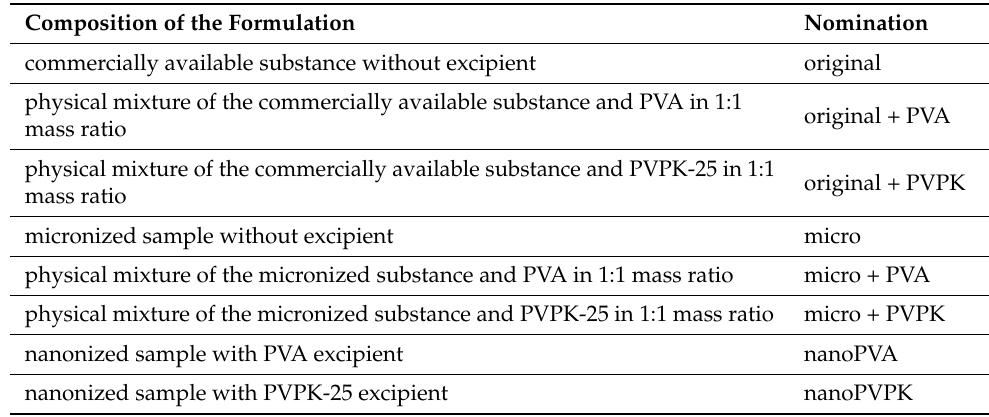
Table 1. Composition of the investigated